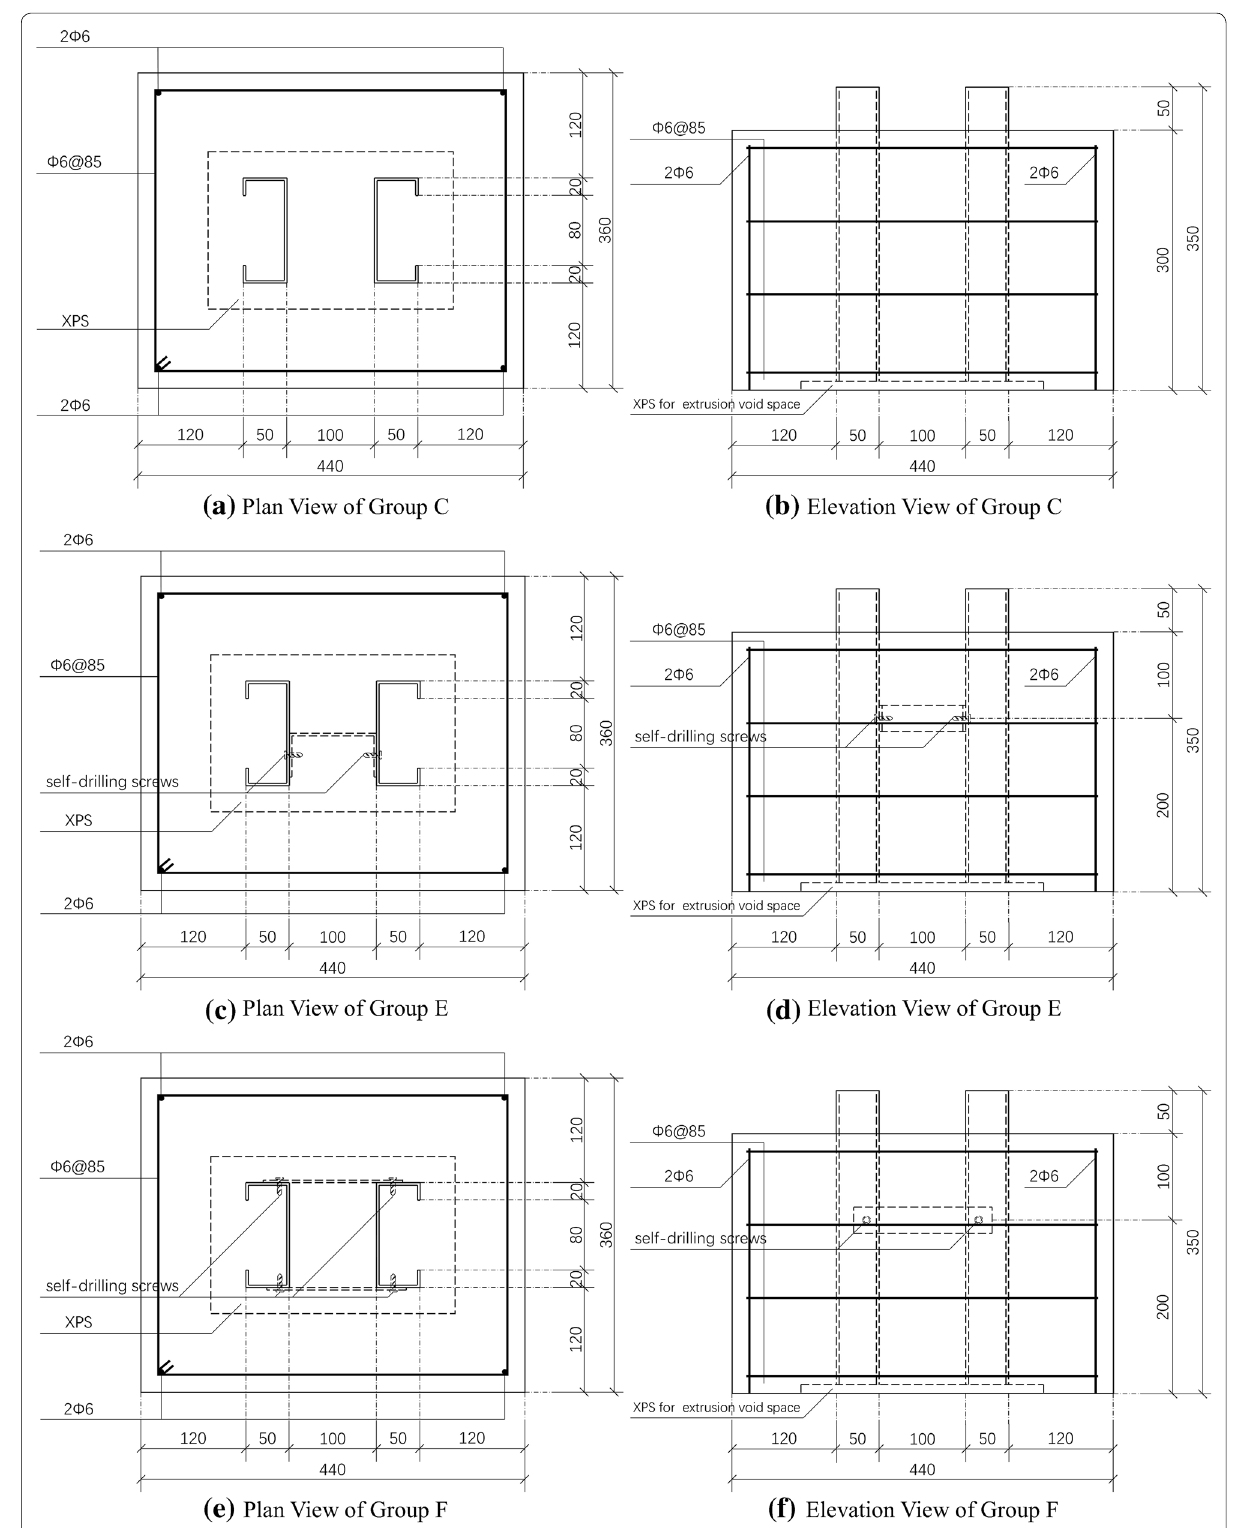
Fig. 1 Sections of foam concrete specimens and C-Channels (XPS—extruded polystyrene to provide extrusion cavity, all dimensions in